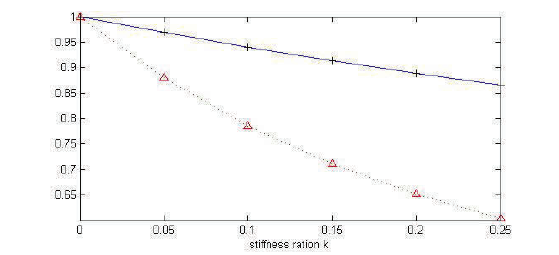
Figure 3. Displacement of qtr. Span with v=10 m/s. Figure 2. Comparison of frequencies. —:Present solution of ! 1 =! 0 ; +:FEM solution of ! 1 =! 0 (cid:1) (cid:1) (cid:1) :Present solution of ! 2 =.4! 0 / ; (cid:129) :FEM solution of ! 2 =.4! 0 /